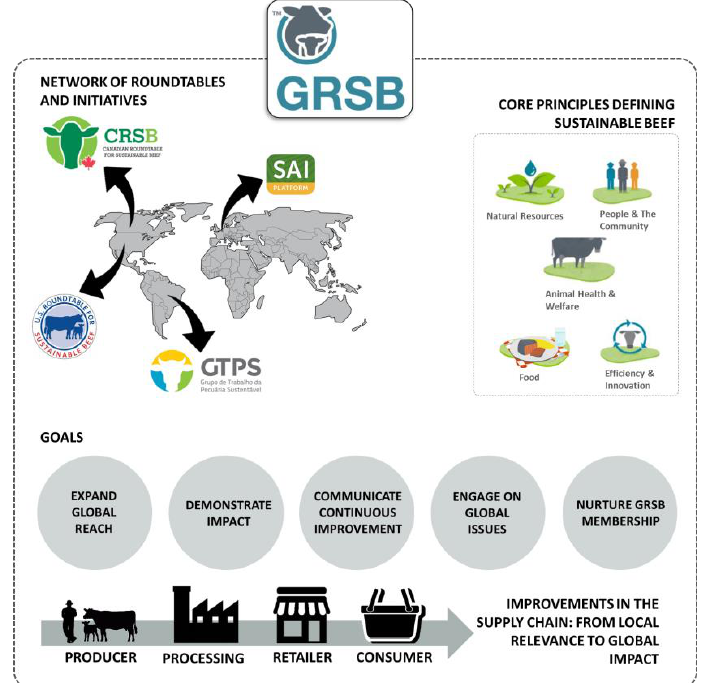
Figure 1. Schematic representation of the multi-stakeholder initiative, Global Roundtable for Sustainable Beef (GRSB), and associated national roundtables and initiative: (1) Canadian Roundtable for Sustainable Beef (CRSB); (2) US Roundtable for Sustainable Beef (USRSB); (3) Brazilian Roundtable on Sustainable Livestock (GTPS); and (4) Sustainable Agriculture Initiative (SAI) Platform. The figure shows GRSB core principles defining sustainable beef, and sustainability goals.